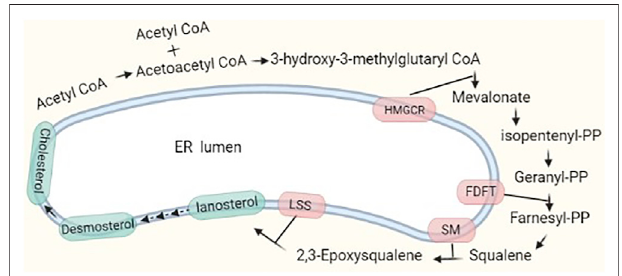
FIGURE 1 | Major pathway of cholesterol synthesis in cells. Two molecules of acetyl-CoA condense and form HMG-CoA with the addition of a third acetyl-CoA molecule. The process to form cholesterol involves nearly 30 reaction steps. There are two rate-limiting steps catalyzed by HMGCR and SM.